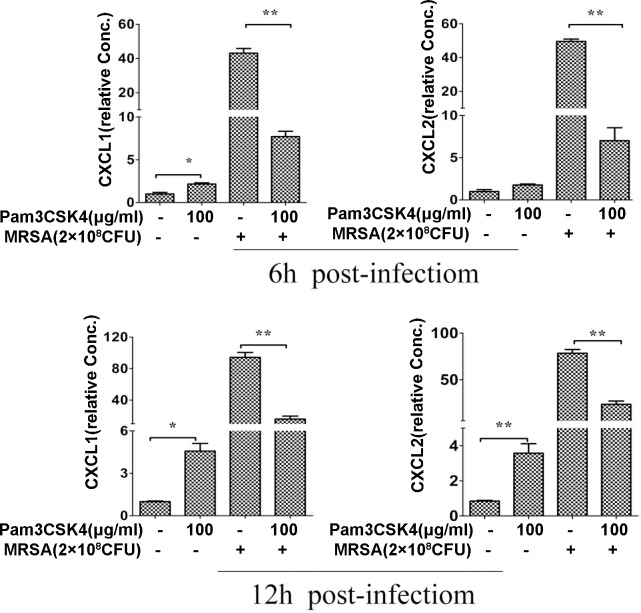
Pam3CSK4 pretreatment reduces expression of neutrophil-inducing chemokines.Lung tissues were collected and homogenized at indicated times after MRSA infection. Kinetics of cytokine mRNA levels of CXCL-1 and CXCL-2 were tested in mouse lung at 6 h and 12 h using qPCR. Data are expressed as the mean ± SEM of 3–5 mice/time from three independent experiments. Note: *P<0.05 or **p<0.01 versus saline-treated mice.